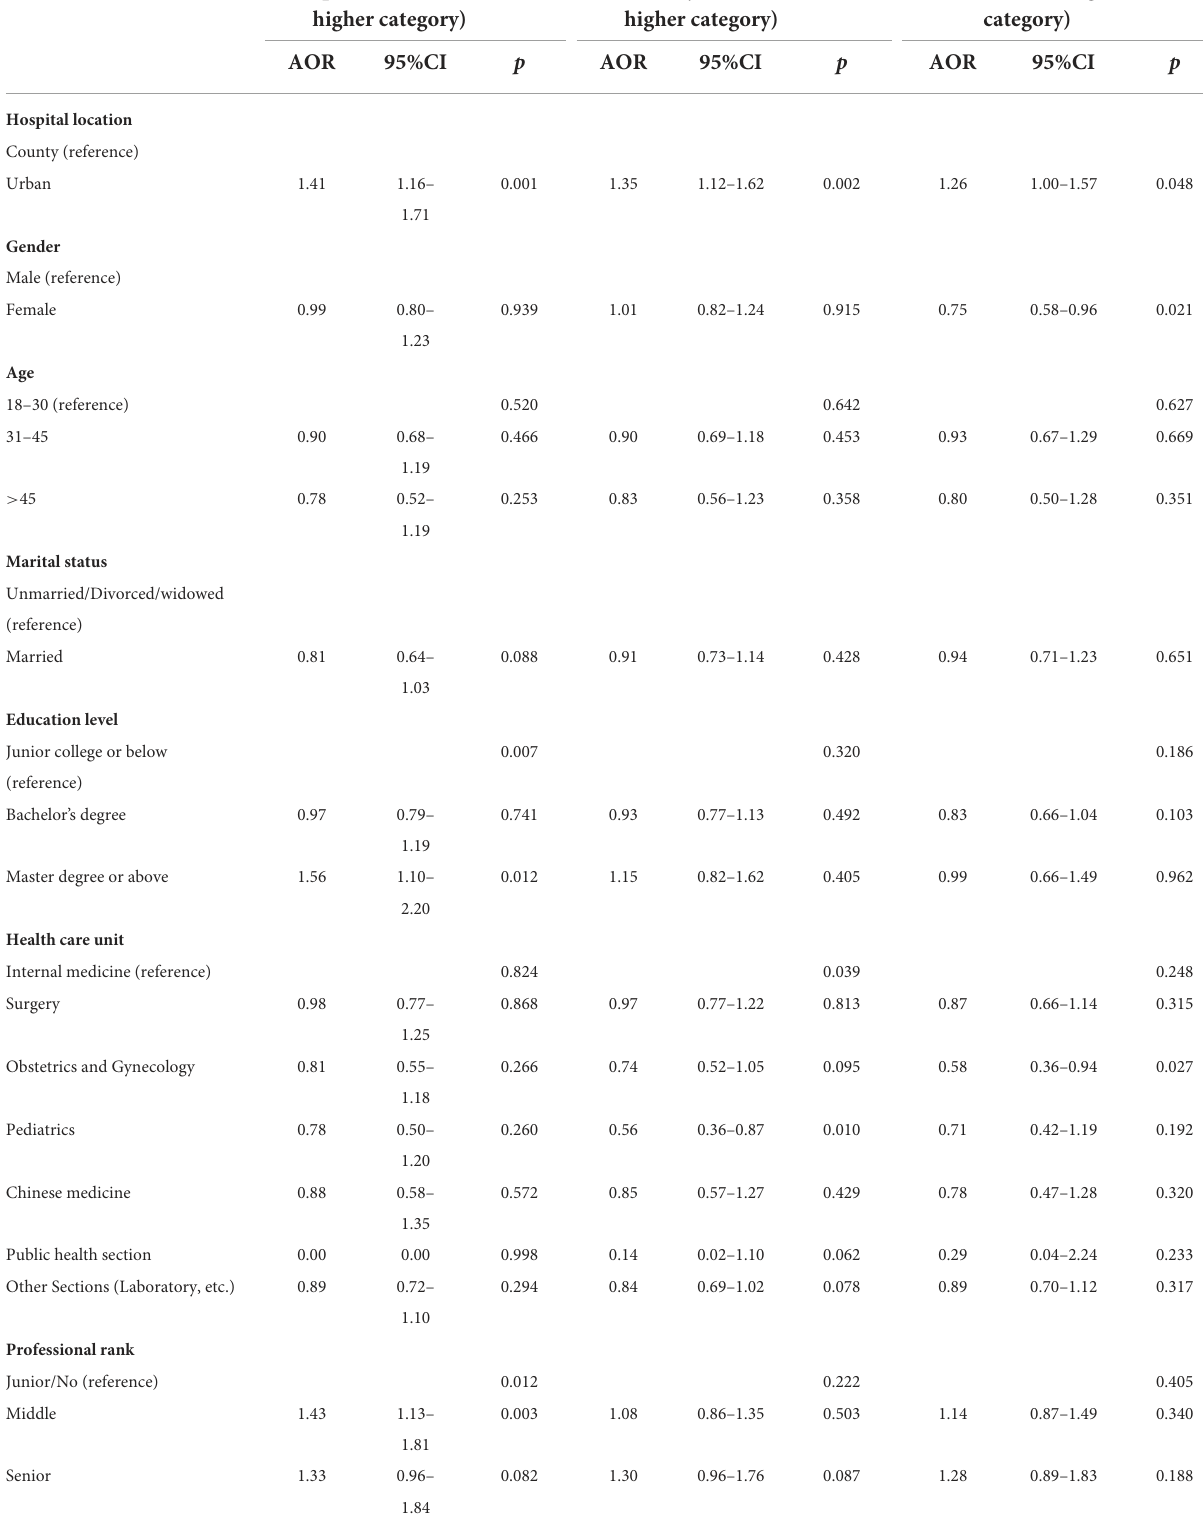
TABLE 5 Factors associated with symptom of depression, anxiety, and